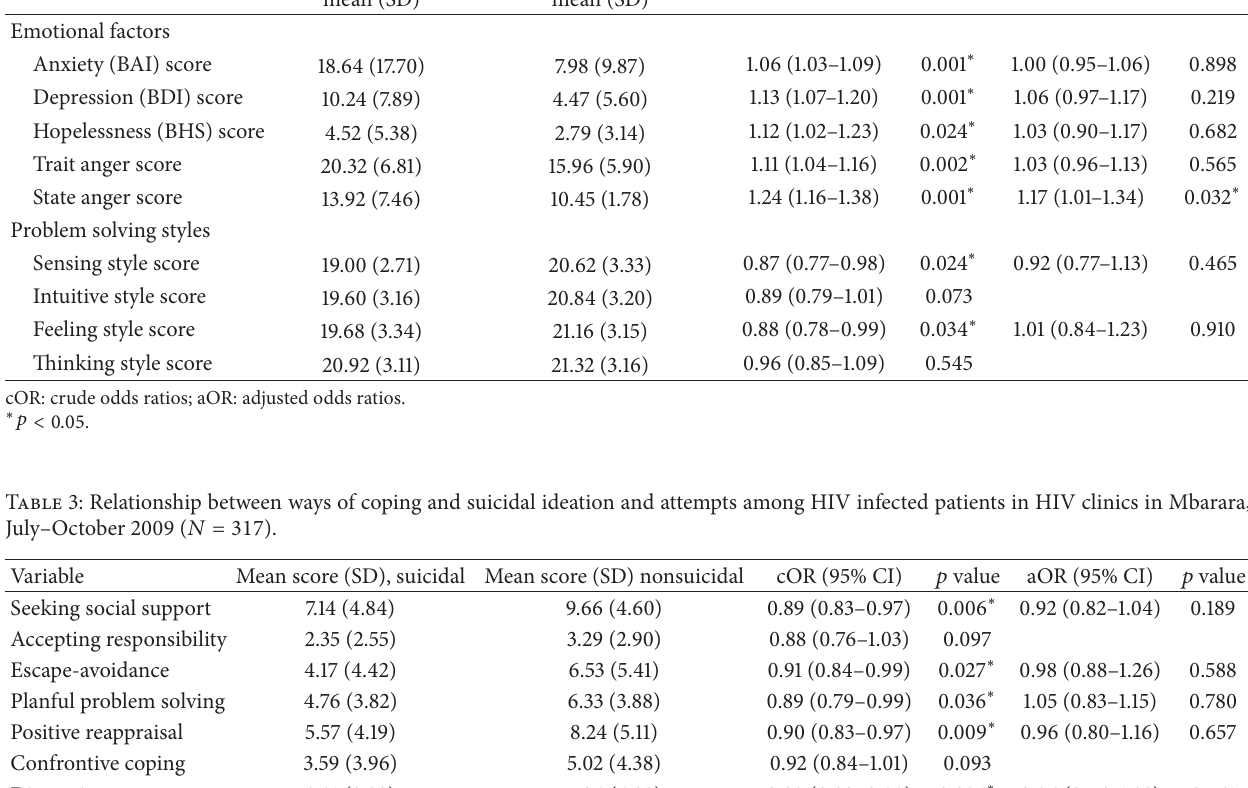
Table 2: Psychological correlates of suicidal ideation and attempt in HIV infected patients in HIV clinics in Mbarara ( 𝑁 = 226 ). Independent variable